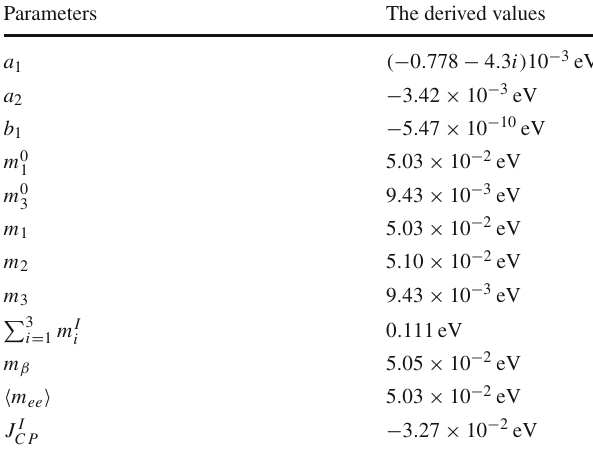
= 0 . 051eV in IH 2